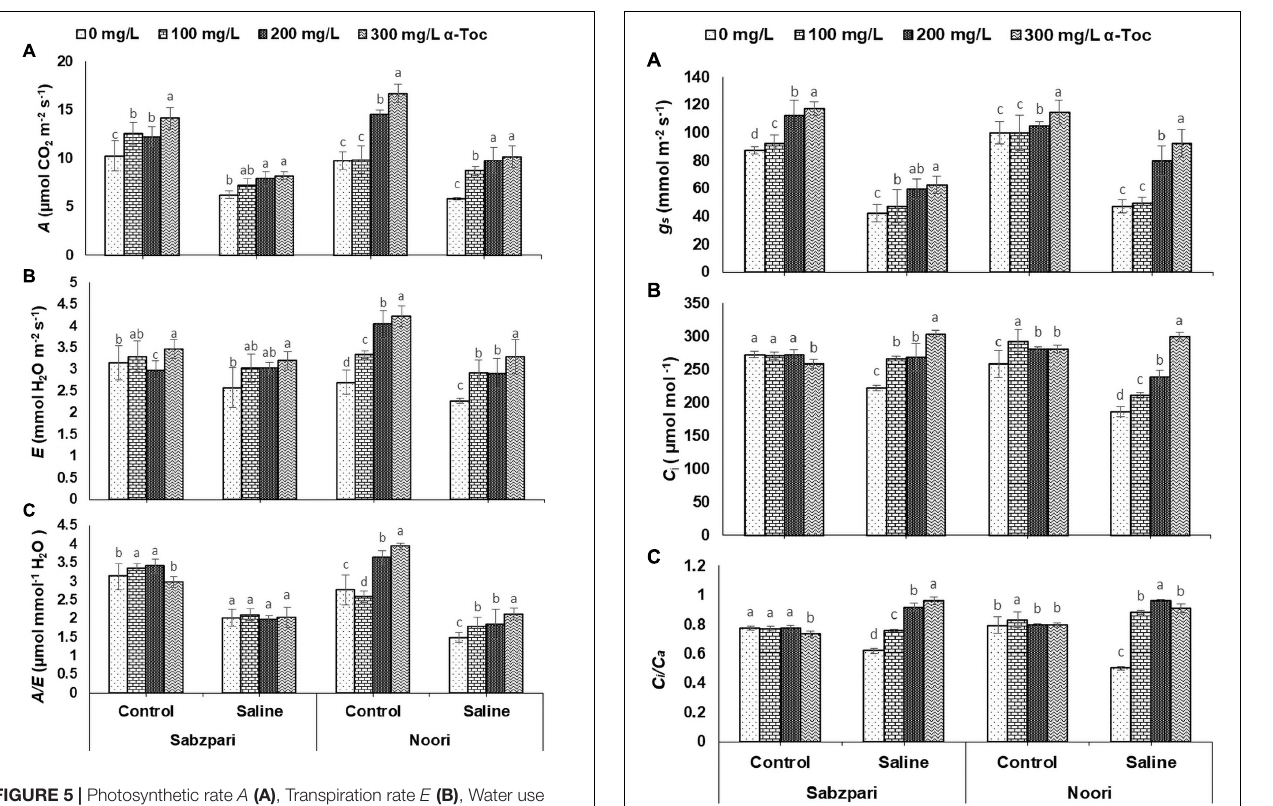
FIGURE 5 | Photosynthetic rate A (A) , Transpiration rate E (B) , Water use efficiency A / E (C) , of okra varieties sprayed with different levels of α -tocopherol under saline conditions. Values represent means ± S.D. Significant differences among row spacing were measured by the least significant difference (LSD) at p > 0.05 and indicated by different letters.